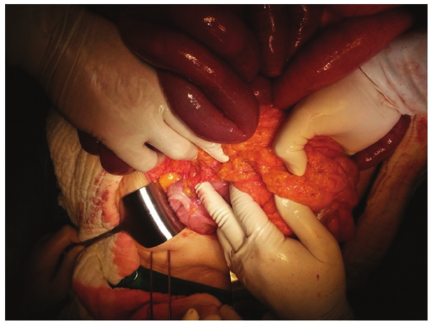
Figure 3: The place where terminal ileum comes out of transverse